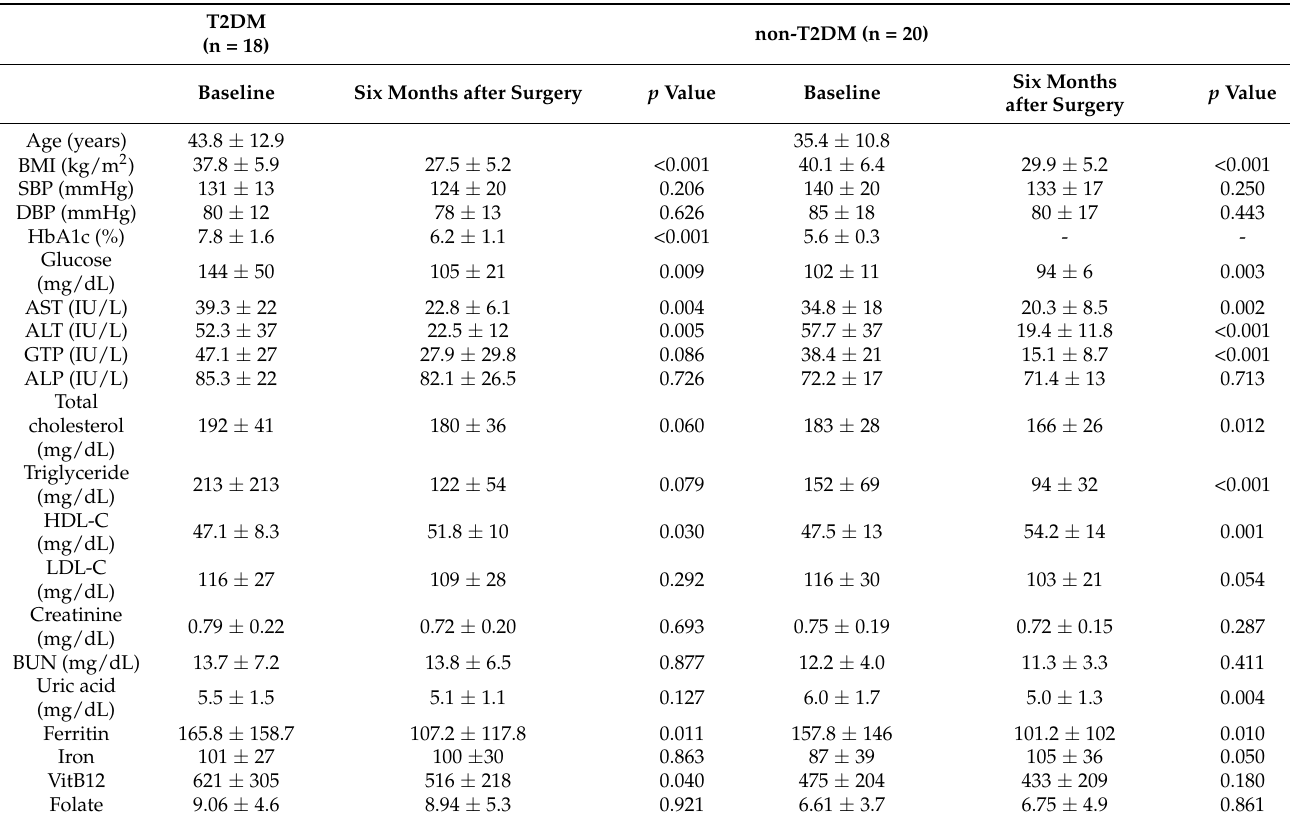
Table 2. Serum indices at baseline and six months after bariatric surgery in patients with T2DM and non-T2DM.